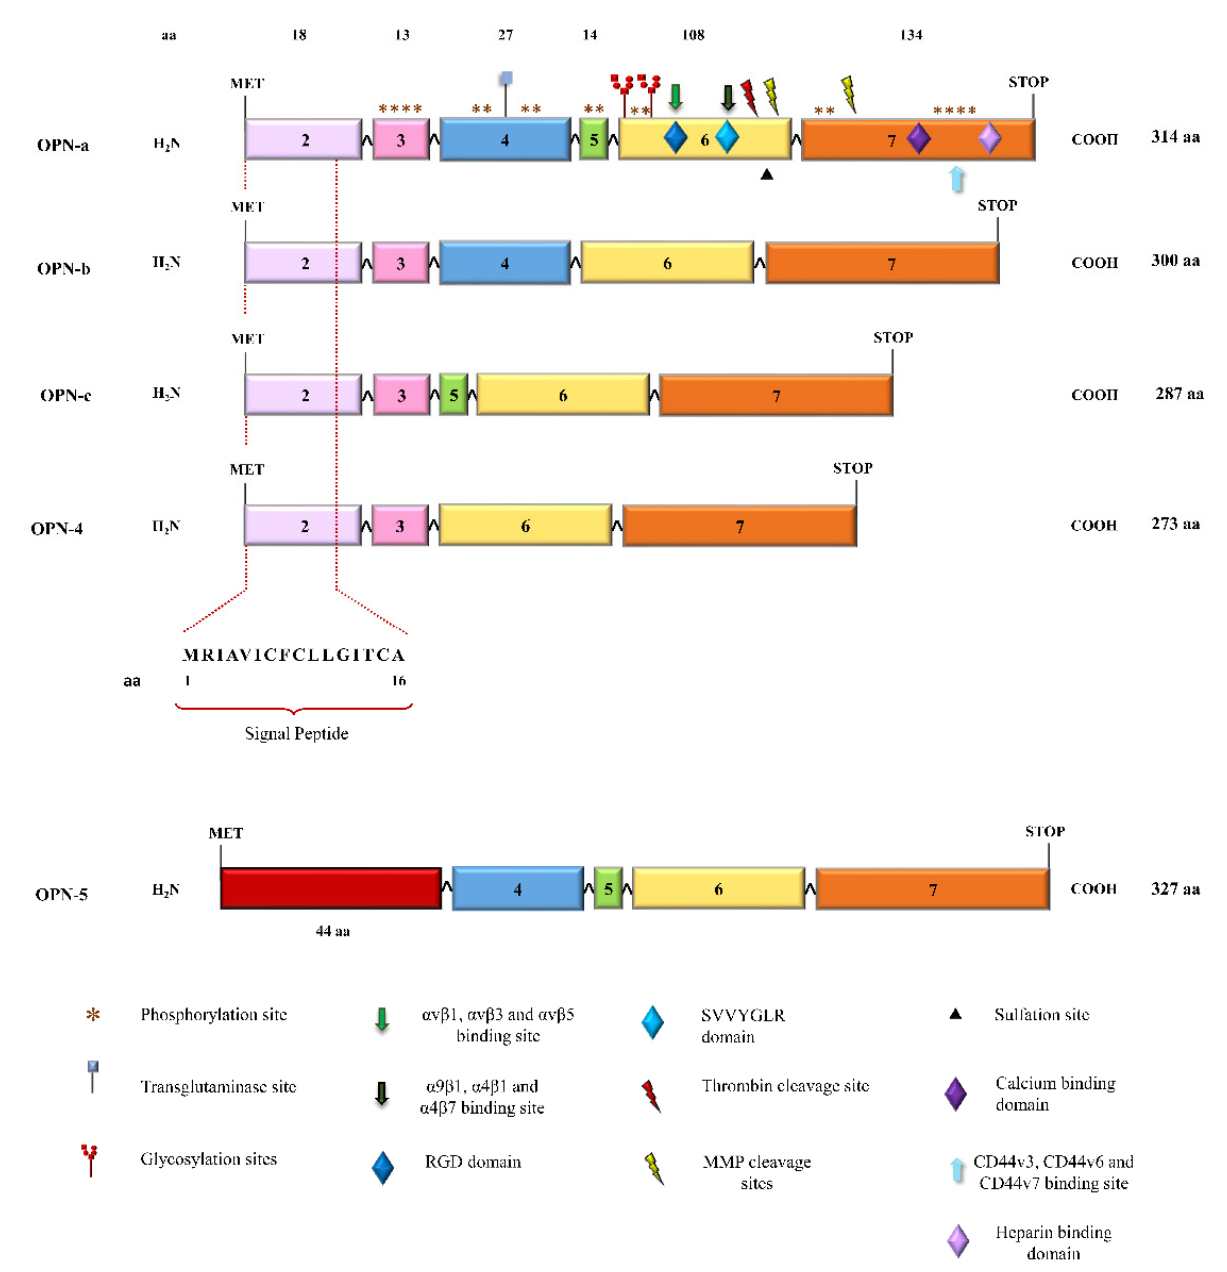
Figure 2. Schematic representation of OPN splice variants. The canonical translation start site is located on exon 2, with the first 16 amino acids coding for the signal peptide (SP). Exon 4 has an important site for transglutaminase binding. Exon 6 has glycosylation, sulfation, thrombin, and MMP cleavage sites. Exon 6 has the RGD and the SVVYGLR domains, regions where protein binds to different integrins. Exon 7 has calcium and heparin-binding domains and a site for MMP cleavage. Phosphorylation regions are scattered throughout the protein, and each * means one phosphorylation site. This Figure was partially based on information provided in previous reports [18,27,28].